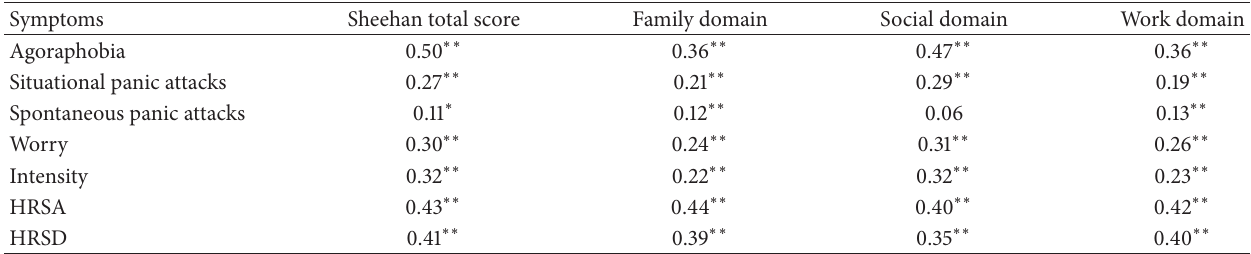
Table 3: Spearman correlation values between symptoms and disability scores.